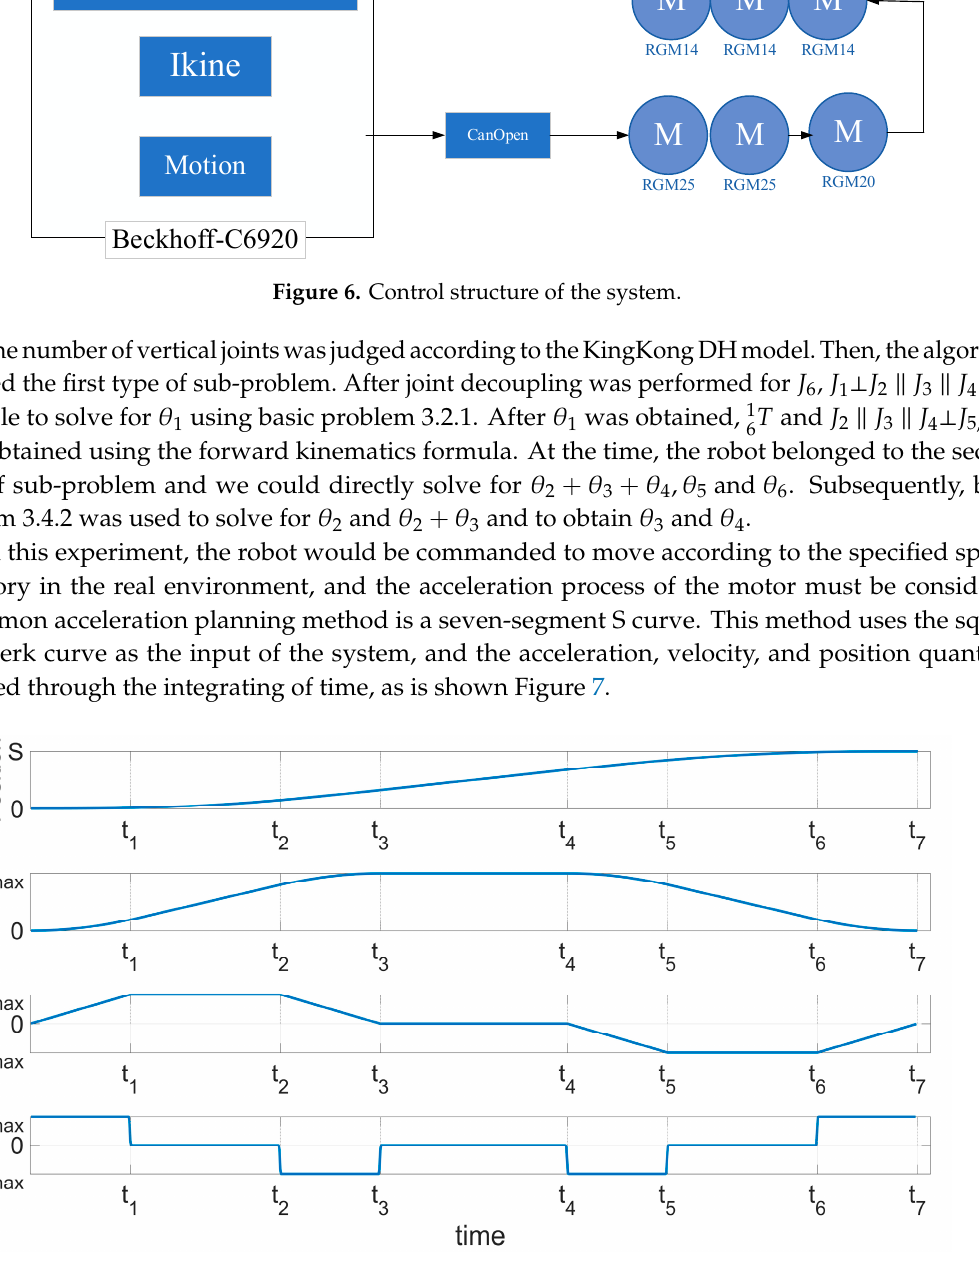
Figure 6. Control structure of the system.